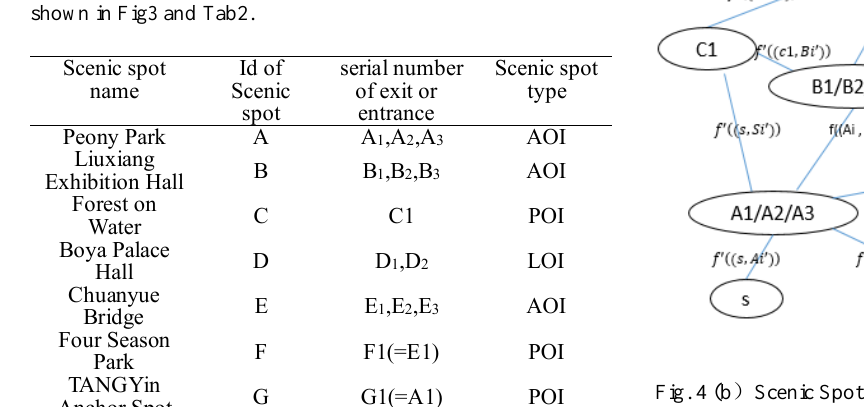
Fig. 4 (b ） Scenic Spot Double-weighted Graph Model As shown in Fig. 4, both traditional scenic spot model